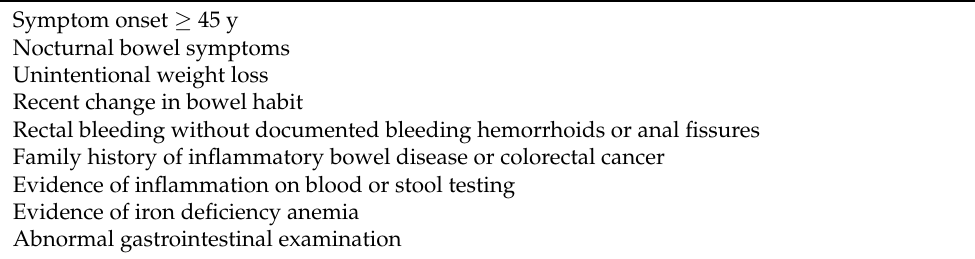
Table 4. Lower gastrointestinal alarm features that require colonoscopy to rule out organic causes